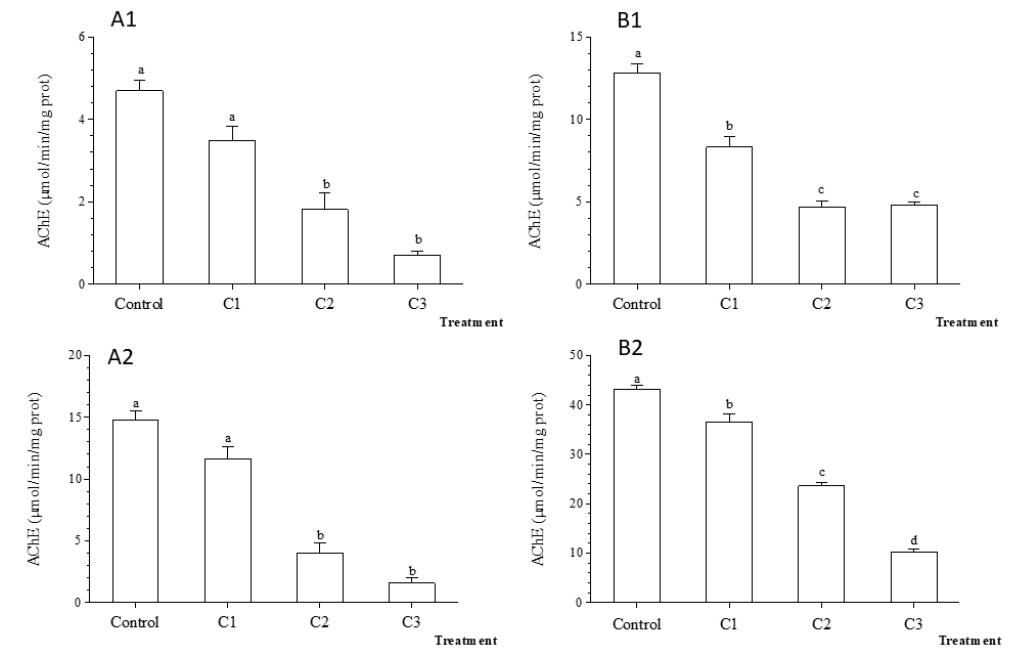
Figure 9. Acetylcholinesterase (AChE) activity ( ± standard deviation) in the freshwater mussel Unio ravoiseri after exposure to Control and three concentrations of Titanium dioxide nanoparticles during 48 h and 7 days in gills, respectively ( A1 ) and ( A2 ) and in digestive gland ( B1 ) and ( B2 ). Bars represent the group means ± SE; a, b, c, d: data not sharing a common letter are significantly different using Tukey’s HSD test ( p < 0.05).